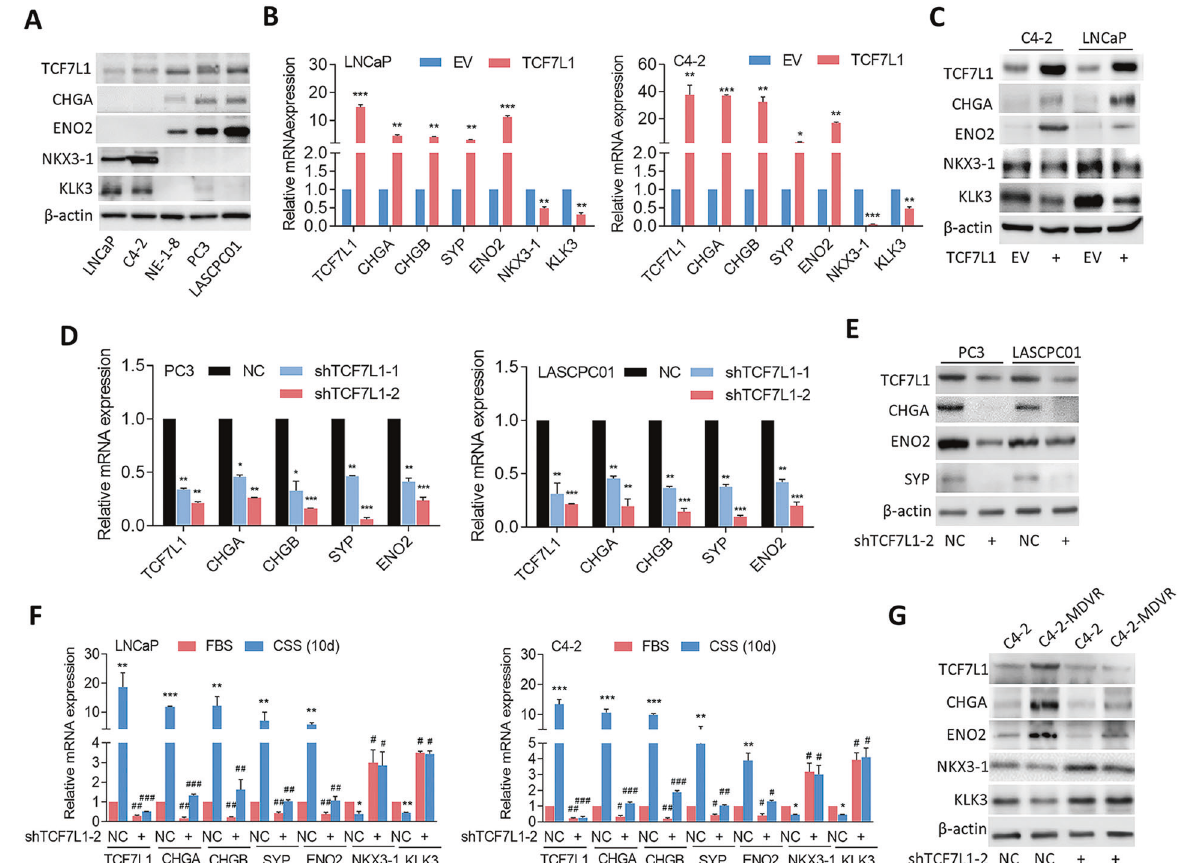
Fig. 4 ADT-upregulated TCF7L1 promotes the NED of PCa. A TCF7L1, CHGA, ENO2, NKX3-1, and KLK3 protein levels in various PCa cell lines as determined by immunoblotting. B RT-qPCR showing mRNA levels of TCF7L1, NE markers (CHGA, CHGB, SYP, and ENO2), and androgen- responsive genes (NKX3-1 and KLK3) in LNCaP and C4-2 cells following stable transfection with an empty vector (EV) or a TCF7L1 cDNA vector. * p < 0.05, ** p < 0.01, *** p < 0.001. C TCF7L1, CHGA, ENO2, NKX3-1, and KLK3 protein levels in C4-2 and LNCaP cells following stable transfection with an EV or TCF7L1 expression vector, by immunoblotting. D mRNA levels of TCF7L1 and NE markers in PC3 and LASCPC01 cells following stable transfection with nontarget control (NC) or TCF7L1 shRNA vectors, by an RT-qPCR analysis. * vs. the NC. E TCF7L1, CHGA, ENO2, and SYP protein levels in PC3 and LASCPC01 cells expressing the NC or TCF7L1 shRNA. F mRNA levels of TCF7L1, NE markers, and androgen-responsive genes in LNCaP and C4-2 cells expressing the NC or TCF7L1 shRNA following treatment of cells with FBS-containing or CSS-containing medium for 10 days, by an RT-qPCR analysis. * vs. FBS; # vs. the NC. Data from the quanti fi cation of mRNA are presented as the mean ± SEM, n = 3 per group; by a two-way ANOVA. G Immunoblots showing TCF7L1, CH G A, ENO2, NKX3-1, and KLK3 protein levels in C4-2 and C4-2-MDVR cells expressing the NC or TCF7L1